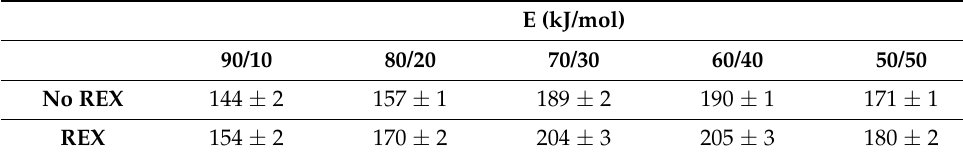
Table 4. Activation energy values of PLA thermal decomposition, with and without reactive extrusion for the random scission